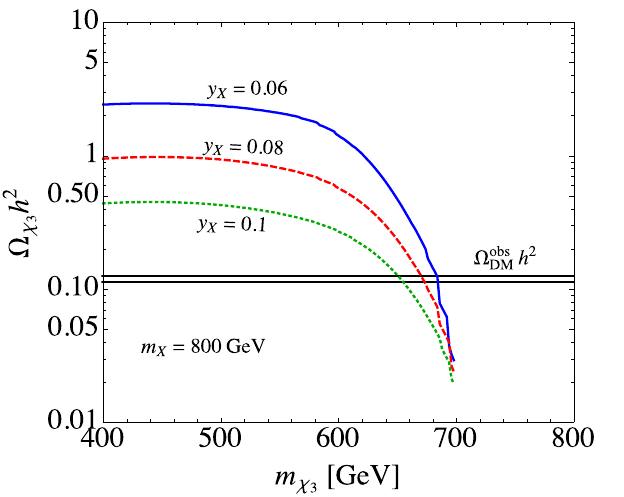
Figure 7 . (cid:31) 3 -DM relic abundance for y X = 0 : 06 (solid), y X = 0 : 08 (dashed), and y X = 0 : 10 (dotted), where m X = 800 GeV is (cid:12)xed, and the horizontal lines denote (cid:10) obs